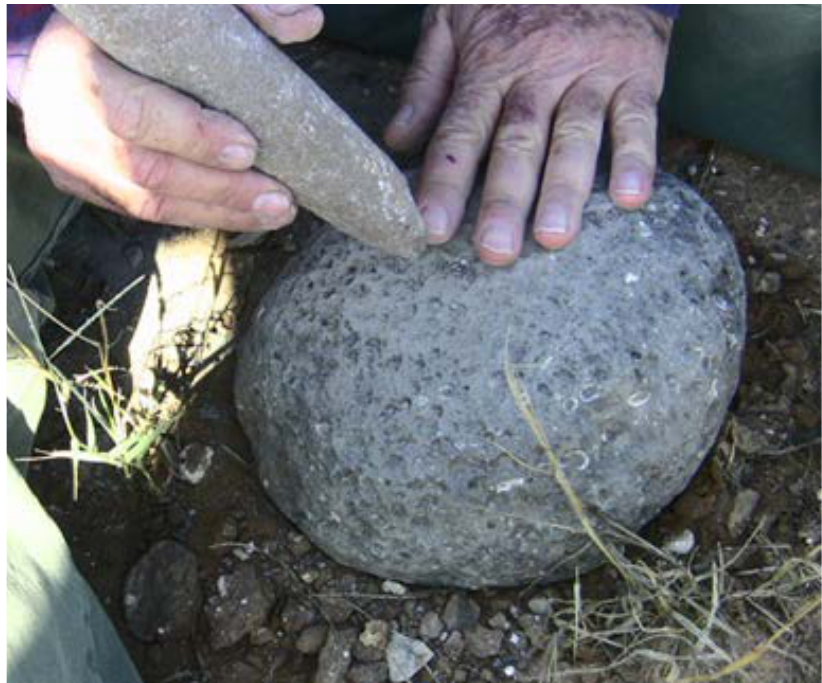
Figure 1. The rounded cobblestone before the cavity was made. The sculptor has the first type of working tool (with a blunt wide point) in his hand.